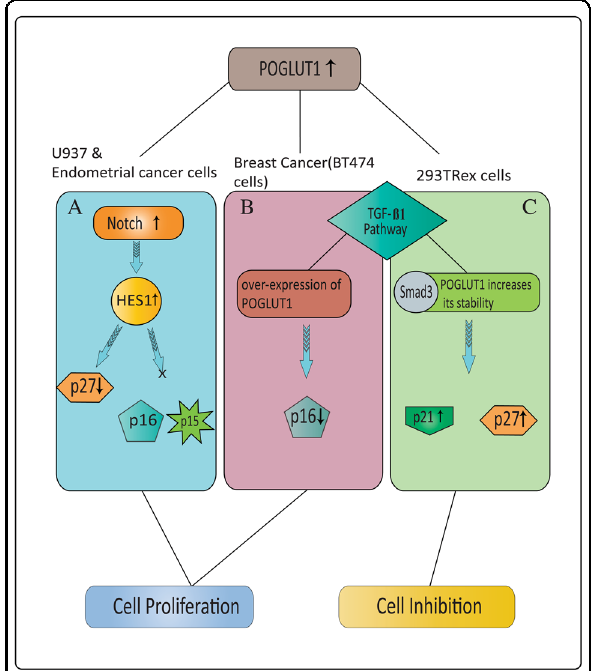
Fig. 6 Partial signaling pathways reported based on speci fi c cell types by POGLUT1 for cell proliferation and inhibition. Dual role of POGLUT1 in cell cycle progression or supression is cell-type speci fi c. Up to now, a complete signaling pathway for cell proliferation or inhibition in response to overexpression of POGLUT1 is not fully explained; however, POGLUT1 ’ association with Notch and TGF- β 1 signaling pathways has been observed. A In U937 and endometrial cancer cells, higher expression of POGLUT1 increases Notch signaling and HES-1 level, which in turn decreases P27 level without altering p15 and p16, and induces cell cycle progression or tumorigenesis. B Evidently, decreased expression level of p16 upon overexpressing POGLUT1 has also been observed, which explains the involvement of more than one signaling route in regulating CDKIs level. Upregulated POGLUT1 reduces Smad3 phosphorylation in breast cancer cells by repressing p16 expression in the presence of TGF- β 1, thus promoting BT474 cell proliferation. C In contrast, overexpression of POGLUT1 in 293TRex cells triggers cell cycle arrest and increases Smad3 protein stability via inhibiting its proteasomal degradation. In fact, POGLUT1 enhances TGF- β 1 signaling by modulating Smad3 expression and increases level of CDKIs p27 and p21, which bind with CDKs enzymes to block cell